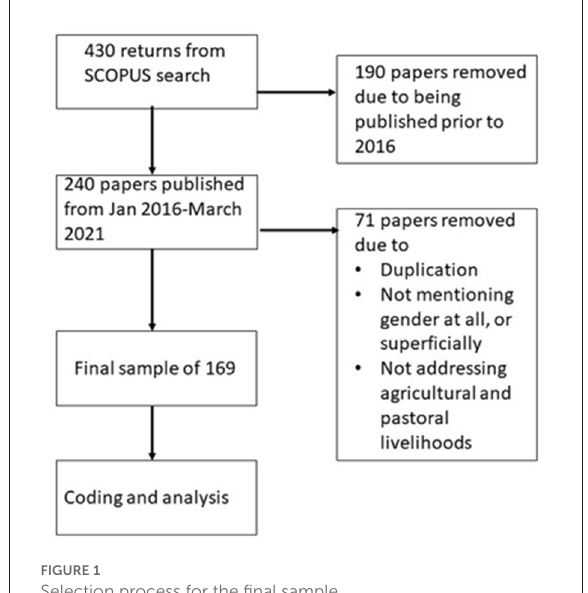
FIGURE1 Selection process for the final